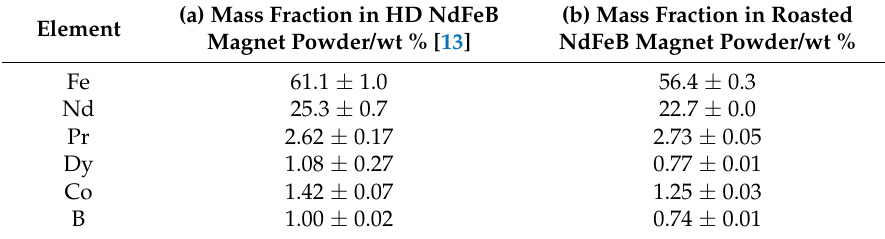
Table 1. Elemental composition, in wt %, of the (a) hydrogen decrepitated (HD) NdFeB totally dissolved in aqua regia for 1 h at 80 ± 1 ◦ C and S:L = 1/10 g/mL and (b) roasted NdFeB powder dissolved in aqua regia for approximately six hours at temperature 23 ± 1 ◦ C and S:L = 0.1/5 g/mL. No residues were left after